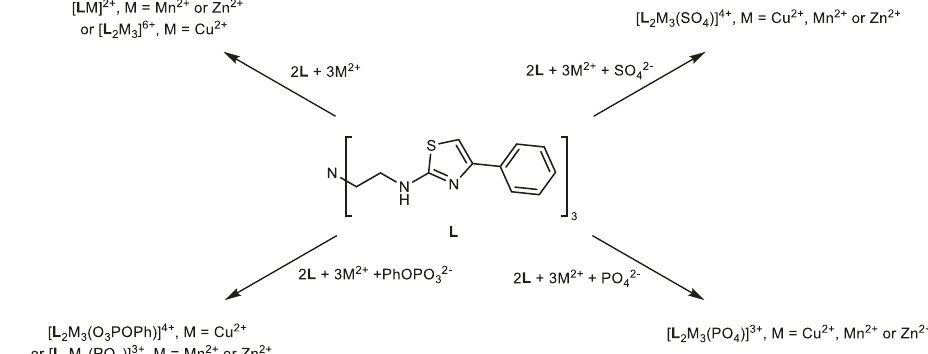
Fig. 1 Differing complexes formed with ligand L, transition metal ions and different anions. Trimetallic assemblies are formed between Cu 2 + and L whereas mononuclear species result upon reaction of either Zn 2 + or Mn 2 + . Trinuclear assemblies can be formed with the latter two cations by templation by SO 4 2 − or PO 4 3 − . PhOPO 3 2 − is encapsulated by the copper complex but is hydrolysed to PO 4 3 − when either the Zn 2 + or Mn 2 + are used. Reaction of the ligand L with Cu 2 + , Zn 2 + and Mn 2 + and